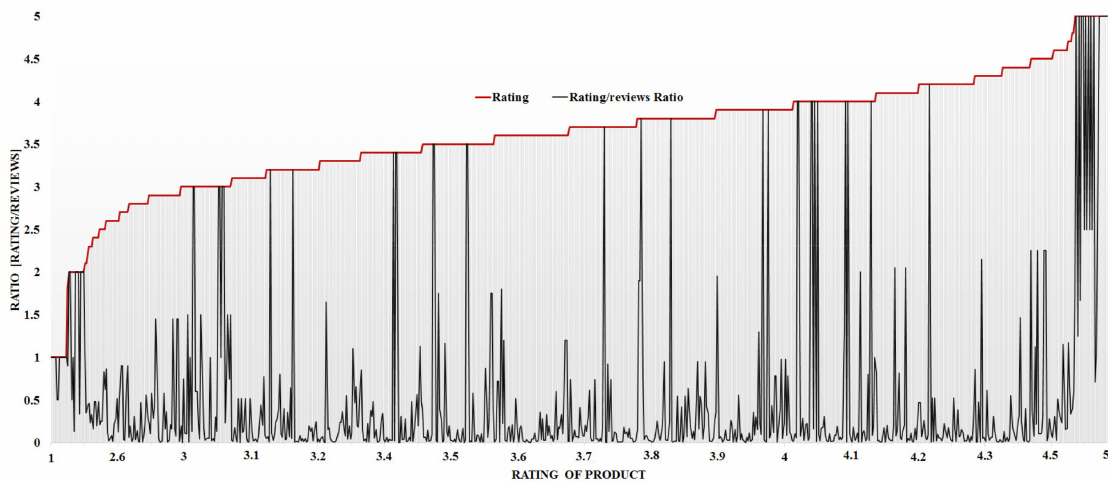
Figure 9. Product wise evaluated MRR value as per product rating for all cellphones in the market.